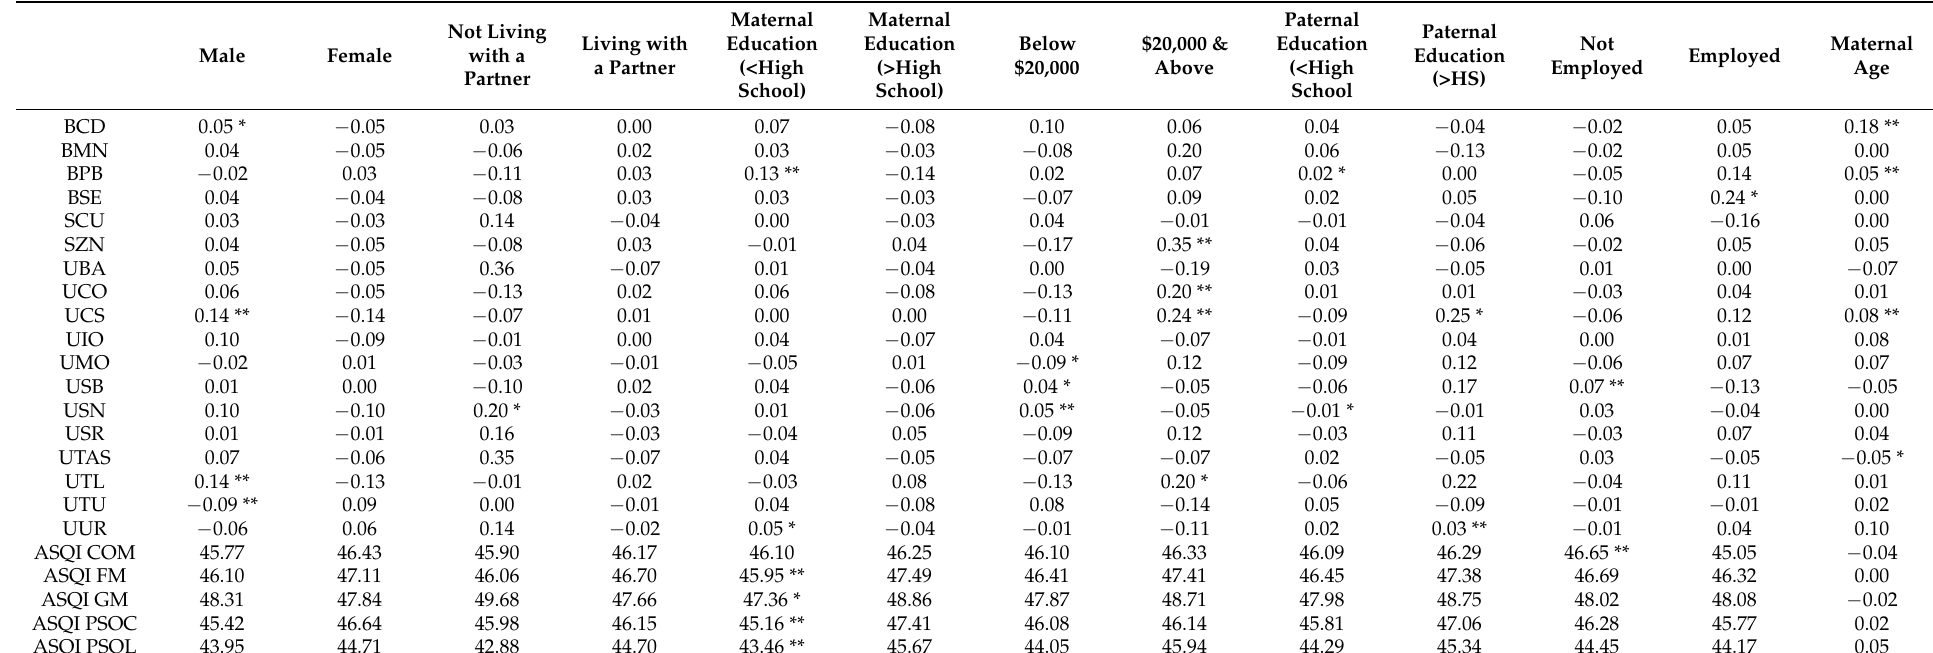
Table 5. Relationships of biospecimen and ASQ:I domain scores to demographic